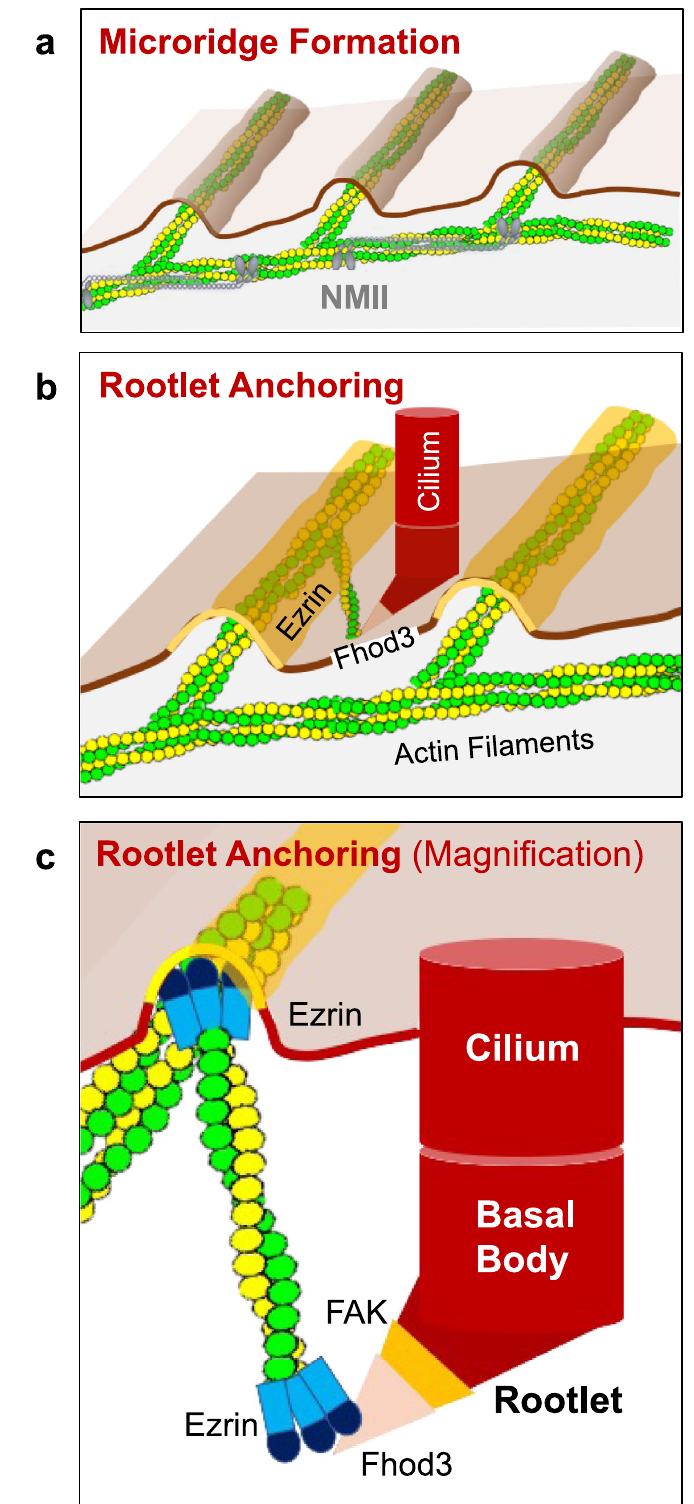
Fig. 8 Microridge-like structures anchor basal body rootlets. a Multiciliated cells of the Xenopus epidermis form microridge-like structures, requiring Nonmuscle Myosin II (NMII). b Actin fi laments, connecting the Fhod3-labeled tip of the anterior rootlet to Ezrin-containing microridges, anchor motile cilia into their fi nal position. c Fhod3 localizes adjacent to FAK to the tip of the anterior rootlet. Ezrin interacts with Fhod3 and represents part of the actin- anchoring complex at the apical plasma